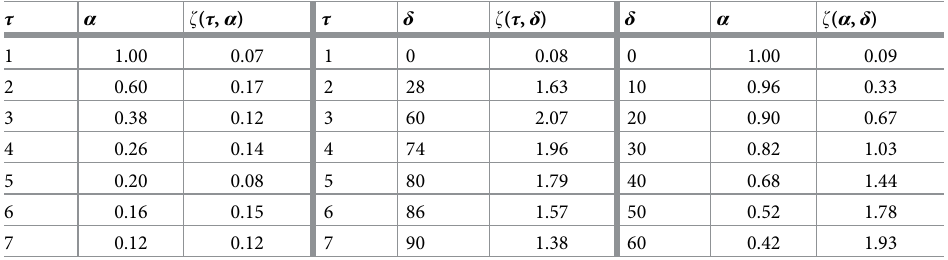
Table 1. Similarity between different communication